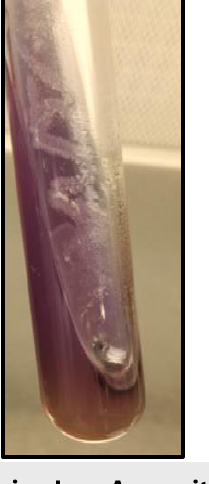
Figure 5: Lysine Iron Agar with Purple Slant and Purple Butt, showing Positive Salmonella